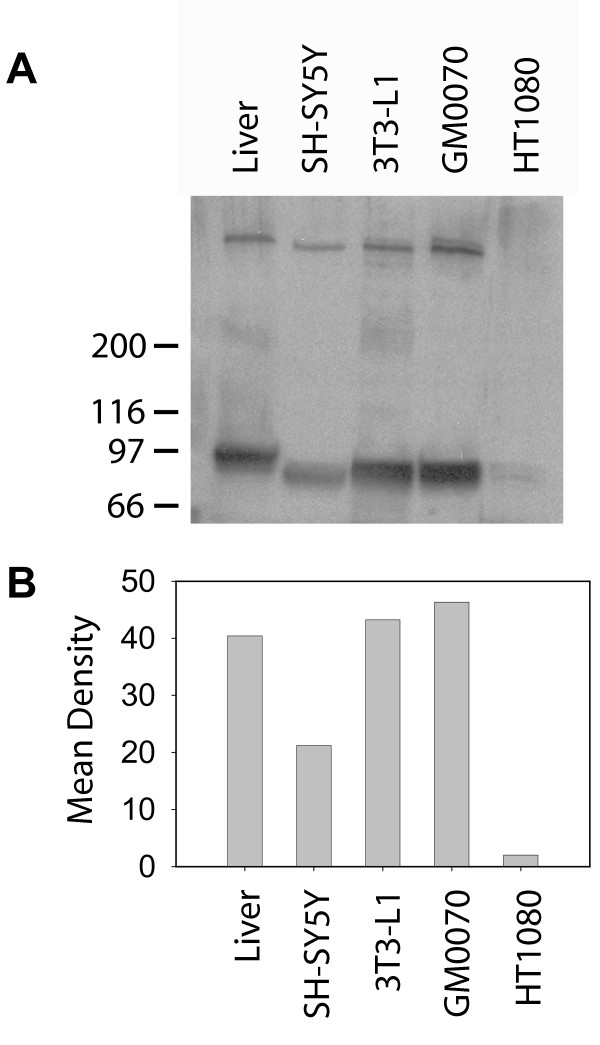
Comparison of LRP expression in various cell lines. (A) Cell lysates were prepared using 1% Triton X-100 detergent, proteins (20 μg/lane) were separated by 6% SDS-PAGE, and immunoblotted with anti-LRP pAb raised against a synthetic peptide derived from the cytoplasmic tail sequence [59]. Bound antibodies were detected by chemiluminescence imaging. Rat liver extract was used as a positive control for LRP expression. (B) Densitometric scans of the 95 kD light chain of LRP in (A).